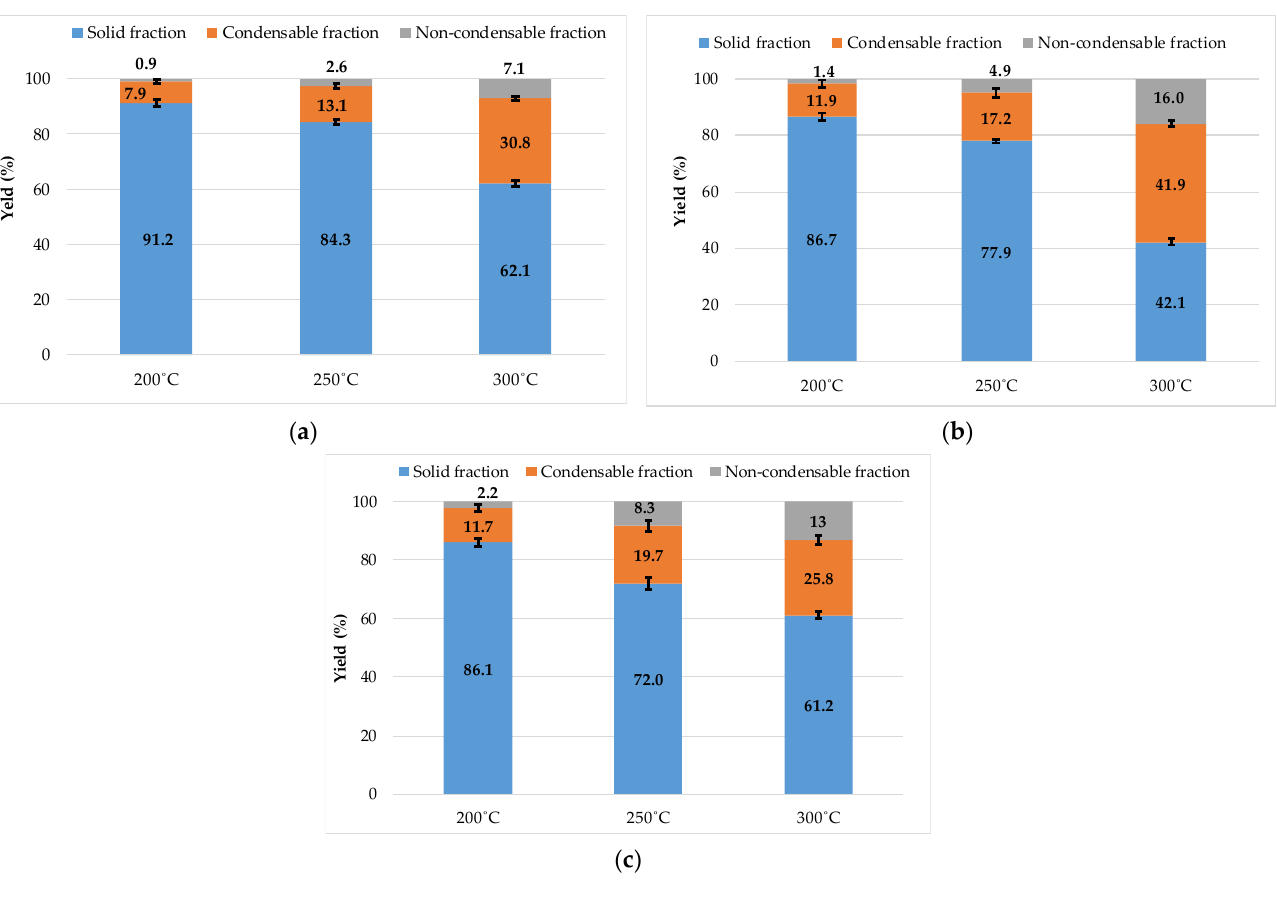
Figure 2. Yields of the products of MW-assisted torrefaction of biomass of different origination: ( a ) softwood, ( b ) wheat straw, and ( c ) peat.